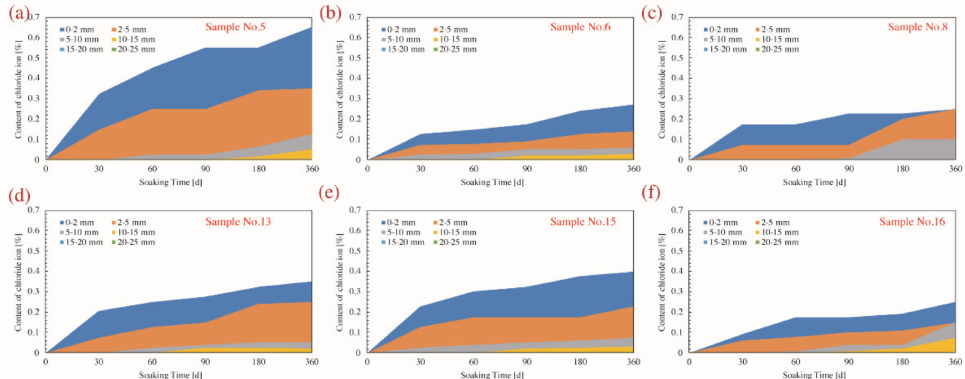
Figure 11. Depth of chloride ion penetration and the content of chloride ion of concrete samples corroded for various days under the dry–wet cyclic immersion environment. ( a ) Sample No.5;